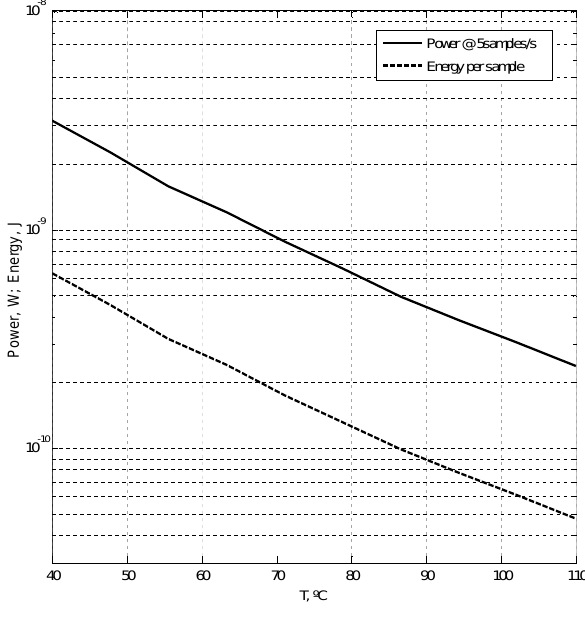
Figure 8. Power consumption at five samples per second and the energy per sample of the sensor under nominal